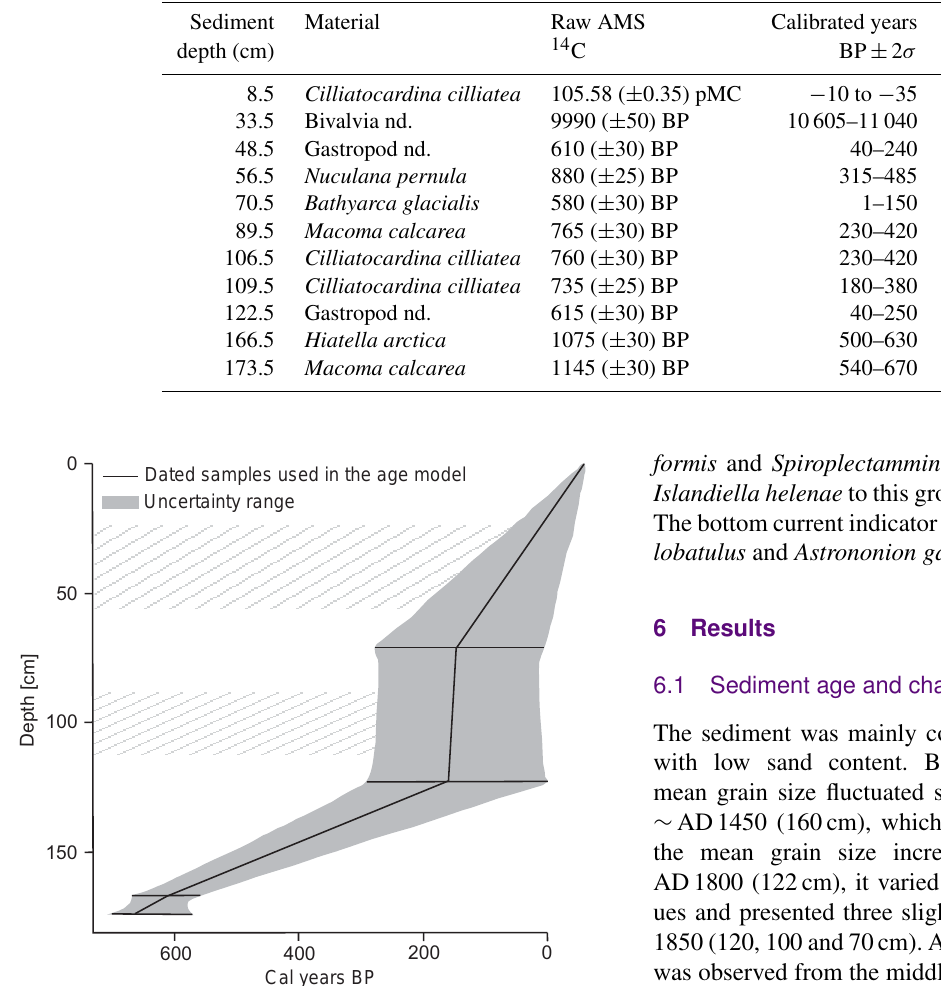
Table 1. Raw AMS 14 C and calibrated dates used for the age model (after Pawłowska et al., 2014). nd.: “not determined”.